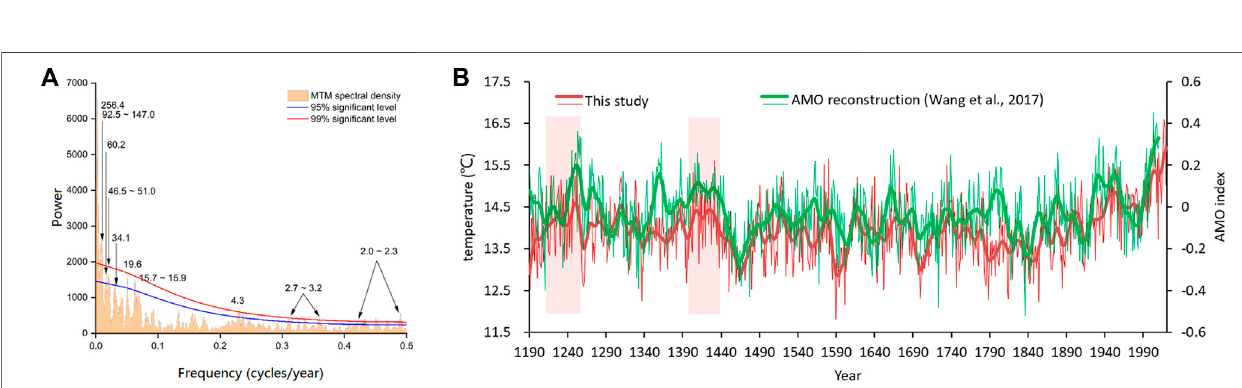
FIGURE 7 | Comparison of the temperature reconstruction (thin lines) and its 20-year low-pass fi ltered values (thick lines) with (A) July-August stream fl ow, (B) January-May stream fl ow, (C) April-July NINO3.4 SST index and (D) August-April AMO index.